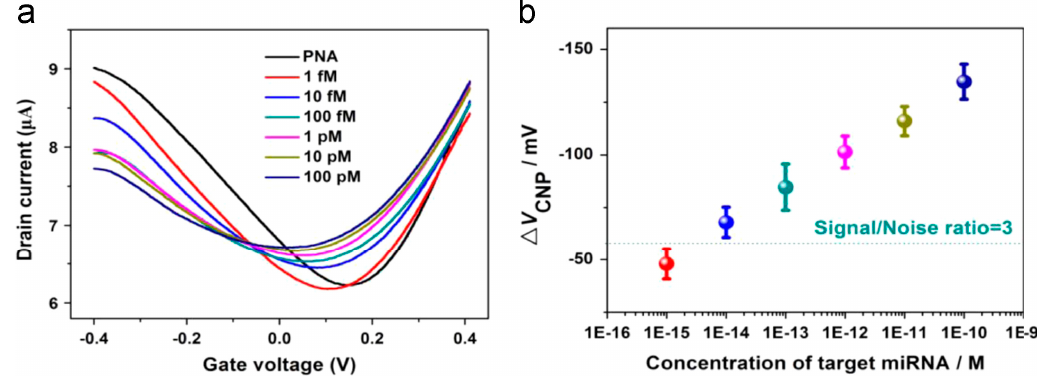
Figure 7. ( a ) The transfer curve of a G-FET decorated with AuNPs with immobilized PNA probe when exposed to increasing concentrations of Let7b miRNA. ( b ) It can be noted that V D progressively decreases in V g due to an n-doping effect of the graphene by miRNA hybridization. Reprinted from [41], Copyright 2015, with permission from Elsevier